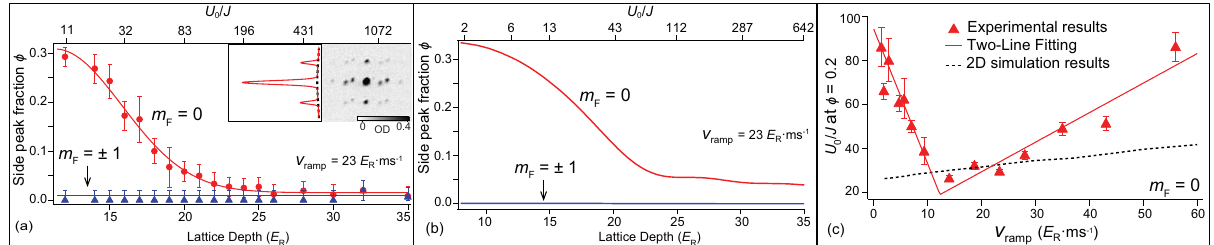
Fig. 3 Quantum critical dynamics probed via super fl uid order parameters. a Red (blue) markers represent the observed side peak fractions ϕ of the m F = 0 ( m F = ± 1) spin components at q / h = 42 Hz during a lattice quench at an intermediate speed, v = 23 E R ⋅ ms − 1 . Here, q is the quadratic Zeeman ramp energy, h is the Planck constant, E R is the recoil energy, m F is the magnetic quantum number, and the unit of v ramp is E R per millisecond ( E R ⋅ ms − 1 ). The red (blue) line is a Gaussian (linear) fi t. The top horizontal axis lists the corresponding U 0 / J , where U 0 is the spin-independent interaction energy and J is the hopping energy. The inset shows a time-of- fl ight (TOF) absorption image of the spin-0 atoms and the corresponding density pro fi le of the top, bottom, center peak populations (red line) and of the background population (dashed line) created by integrating along a narrow vertical slice (including only the top, center, and bottom peaks) of the TOF image and by fi tting to four Gaussian curves. From these fi ttings we can extract ϕ by taking the area of the two side peaks and dividing by the total area. The color scale in the TOF image shows the optical density (OD). b Similar to panel a but derived from the Bose – Hubbard model for 2D lattice-trapped sodium spinor gases (see “ Methods ” ). c Markers represent U 0 / J , where the measured ϕ of the spin-0 atoms equals 0.2, extracted from curves similar to the one shown in panel a but taken at various v ramp . The solid line is a two-line fi t and the dashed line represents the 2D numerical simulation results. Error bars represent one standard